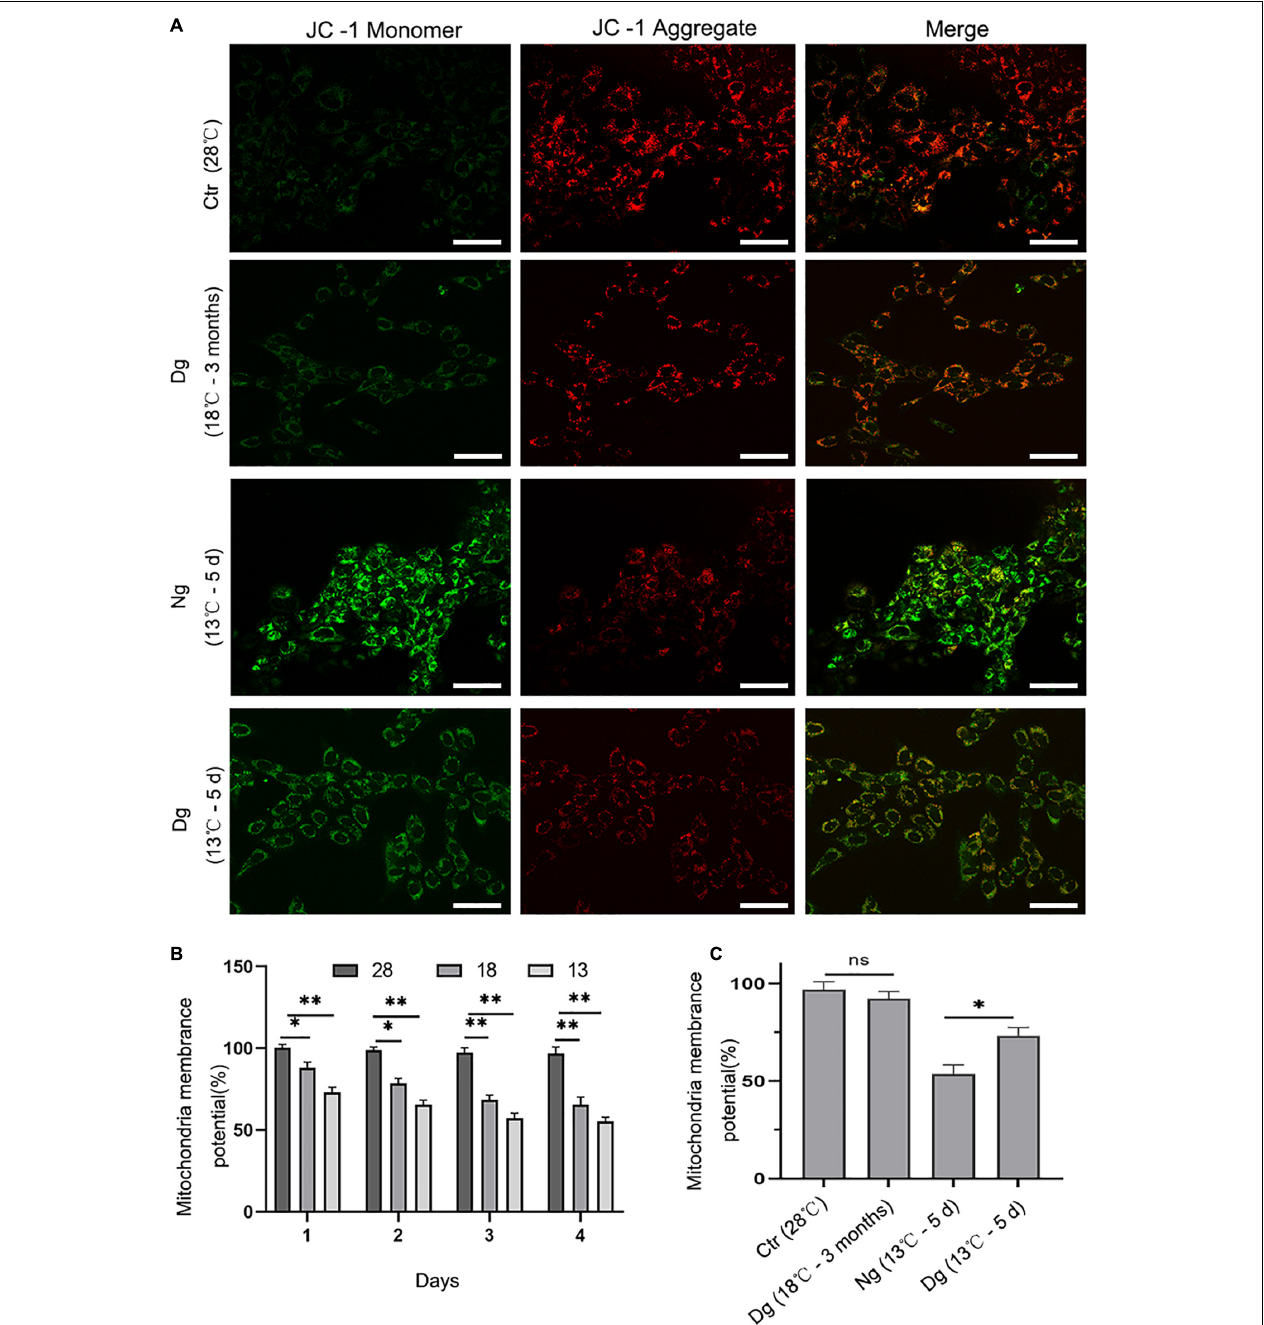
FIGURE 5 | The effect of cold stress on mitochondrial membrane potential. Ctr, the control group; Dg, the domesticated group; Ng, the non-domesticated group. (A) Representative images were scanned by a confocal microscope after staining with JC-1. The red fluorescence indicates high mitochondrial membrane potential, while the green indicates low mitochondrial membrane potential. Scale bar = 50 µ m. (B,C) Quantitative results of mitochondrial membrane potential by flow cytometry. Each experiment was performed in triplicate. The results are presented as the mean ± SD ( n = 3); ∗ P < 0.05, ∗∗ P <